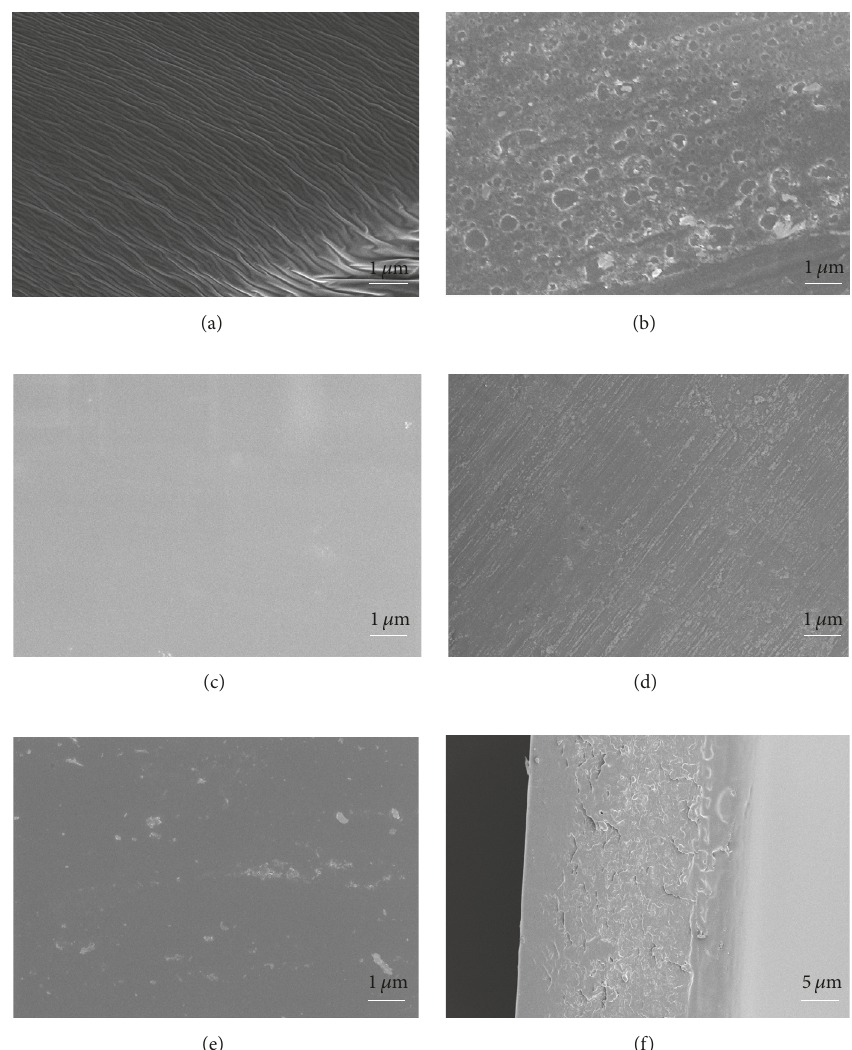
Figure 5: SEM micrographs of the surface of the films based on (a) the pure collagen film, (b) SA film, (c) CS1, (d) CS2, and (e) CS3. SEM micrographs of the cross section appearance of the films based on (f)